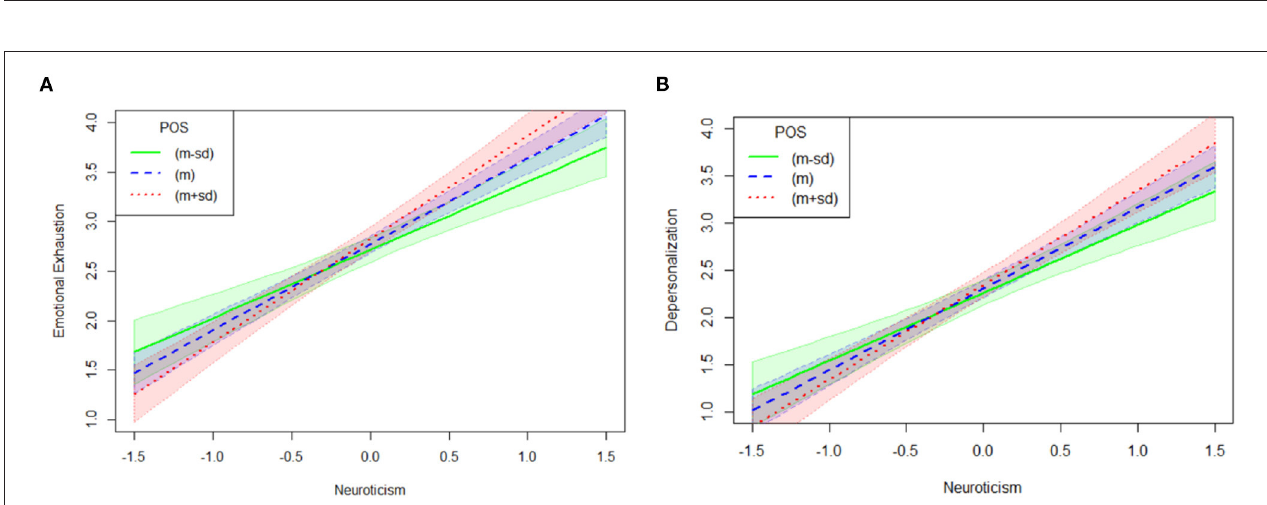
FIGURE 2 | Interaction of neuroticism and POS on emotional exhaustion and depersonalization ( N = 716). POS, perceived organizational support. (A) Indicates the interaction of neuroticism and POS on emotional exhaustion. (B) Shows the interaction of neuroticism and POS on depersonalization.